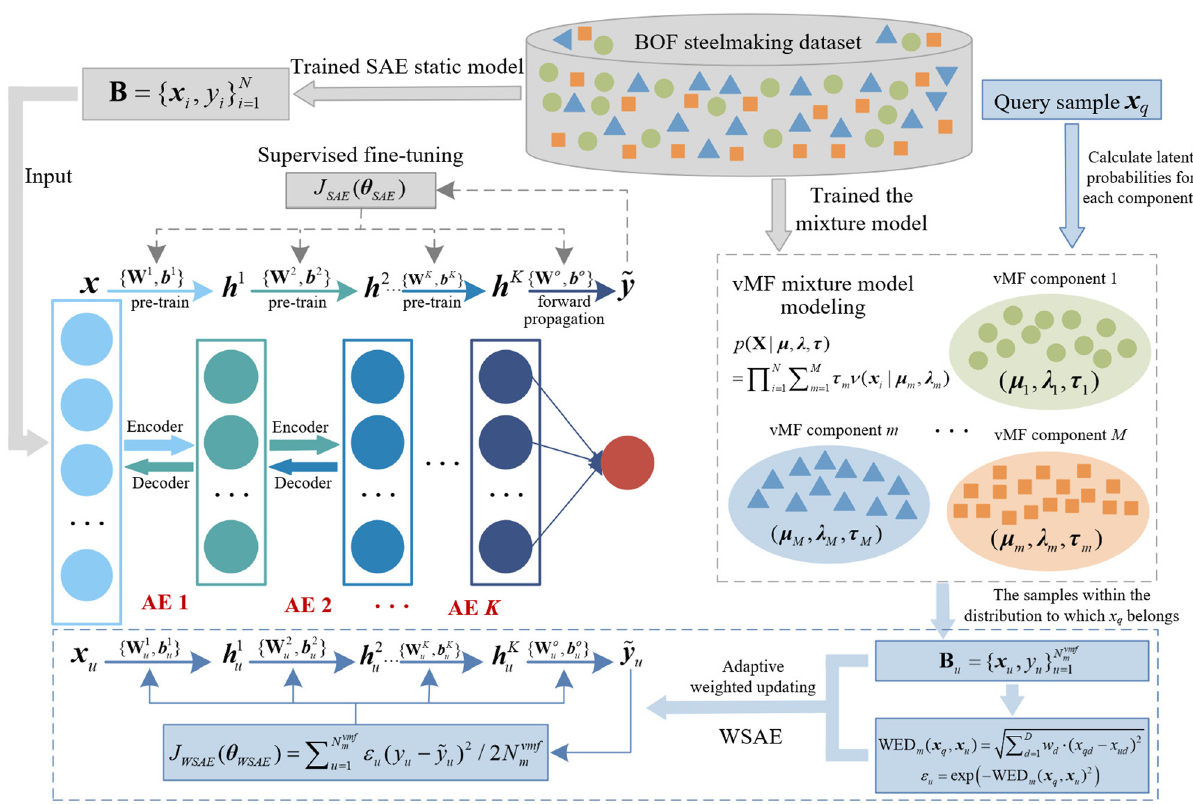
Figure 4: Algorithm diagram of vMF -